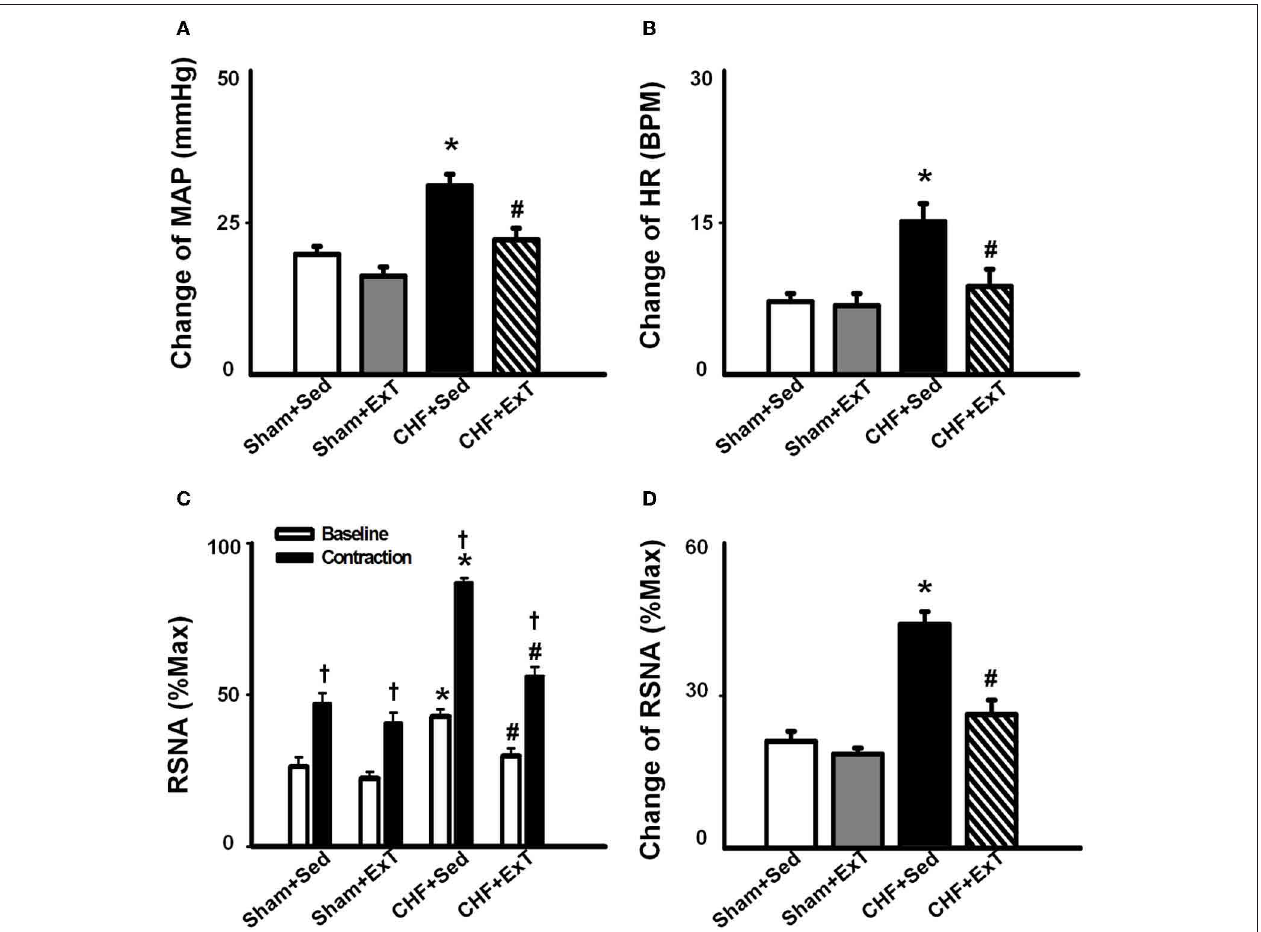
FIGURE 4 | Mean data showing the effects of ExT on pressor (A), heart rate (B) and sympatho-excitatory (D) responses to a 30-s static contraction in sham and CHF rats. Both baseline and contraction-induced RSNA were compared in sham + Sed, sham + ExT, CHF + Sed and CHF + ExT